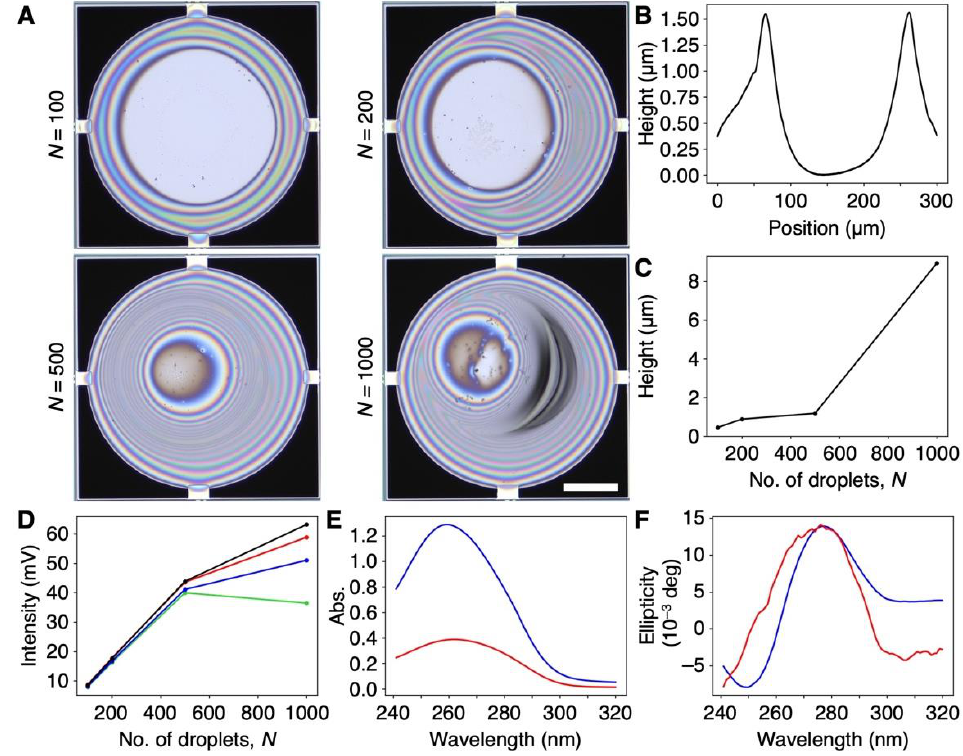
Figure 2. DNA-coated MSS. ( A ) Optical microscope images of the DNA-coated MSS with a different number of inkjet droplets ( N ) ranging from 100 to 1000. Scale bar is 100 µm. ( B ) Height profile of the DNA film on MSS. N = 500. See also Figure S2 for all height profiles. ( C ) Plot of maximum thickness of DNA coated on the MSS as a function of a number of inkjet droplets ( N ). ( D ) Sensitivity to water as a function of DNA film thickness. The relative humidity varied as follows: 20%RH (green), 40%RH (blue), 60%RH (red), and 80%RH (black). ( E , F ) UV–Vis ( E ) and CD spectra ( F ) of a DNA aqueous solution (60 µ g/mL) (blue) and DNA cast on quartz (red). CD spectra of DNA cast on quartz, magnified 10 times.